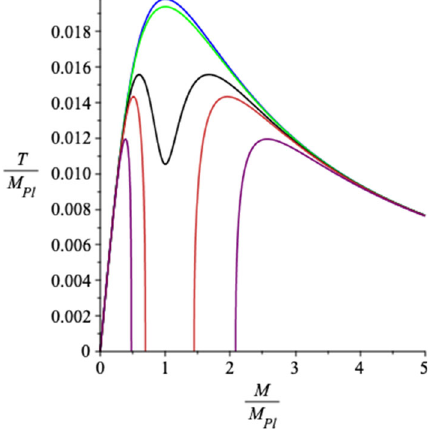
Fig. 7 Hawking temperature curves for the GUP-RN black hole with β = 2 and n = 10 (blue), n = 16 (green), n = 23 (black), n = 25 (red) and n = 30 (purple). The curves for n > 23 have vanishing temperatures at the masses M 1 (left) and M 2 (right) defined by Eq. (49). T = 0 endpoints in the super-Planckian regimecorrespond to stable charged